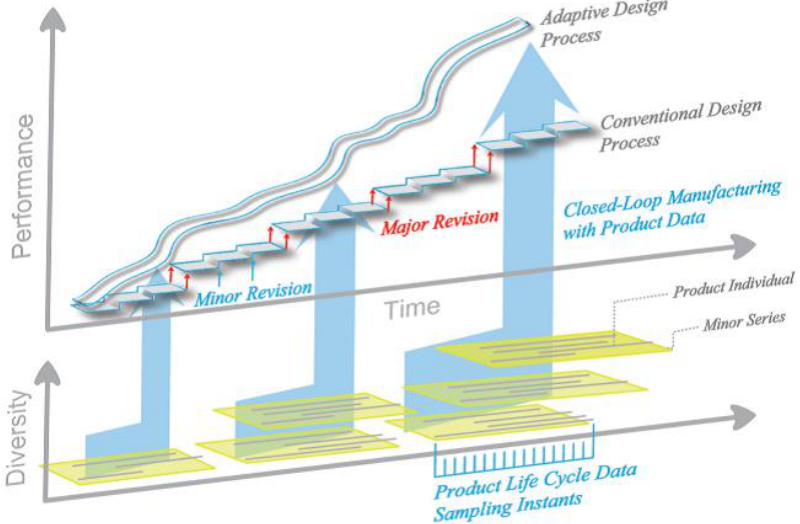
Figure 1. Consequences of the basic concept visualized: From product generations to continuous optimization through gathering and usage of life cycle data in conjunction with flexible production.